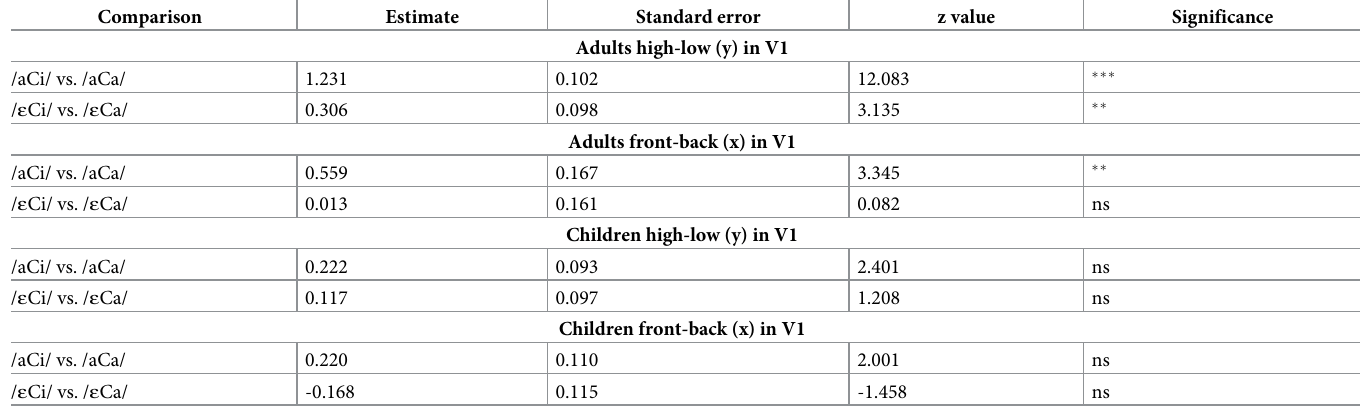
Table 2. Results of comparisons of V 2 for the coordinates of the highest point of the tongue, according to the speaker group (adults and children) and the V 1 level (V 1 = /a/ and V 1 = / ε